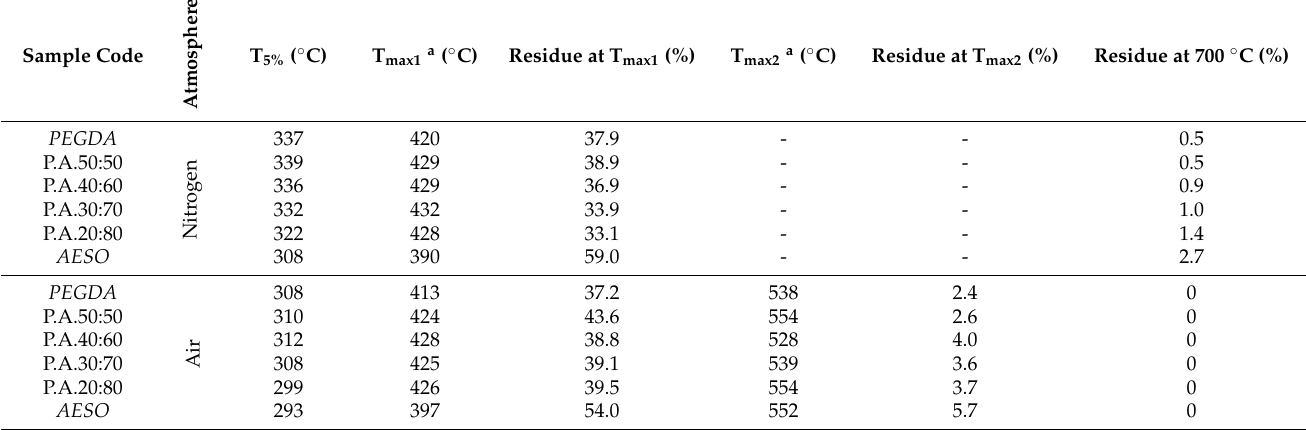
Table 5. Thermogravimetric data for the different AESO / PEGDA 3D-printed systems ( w / w ).